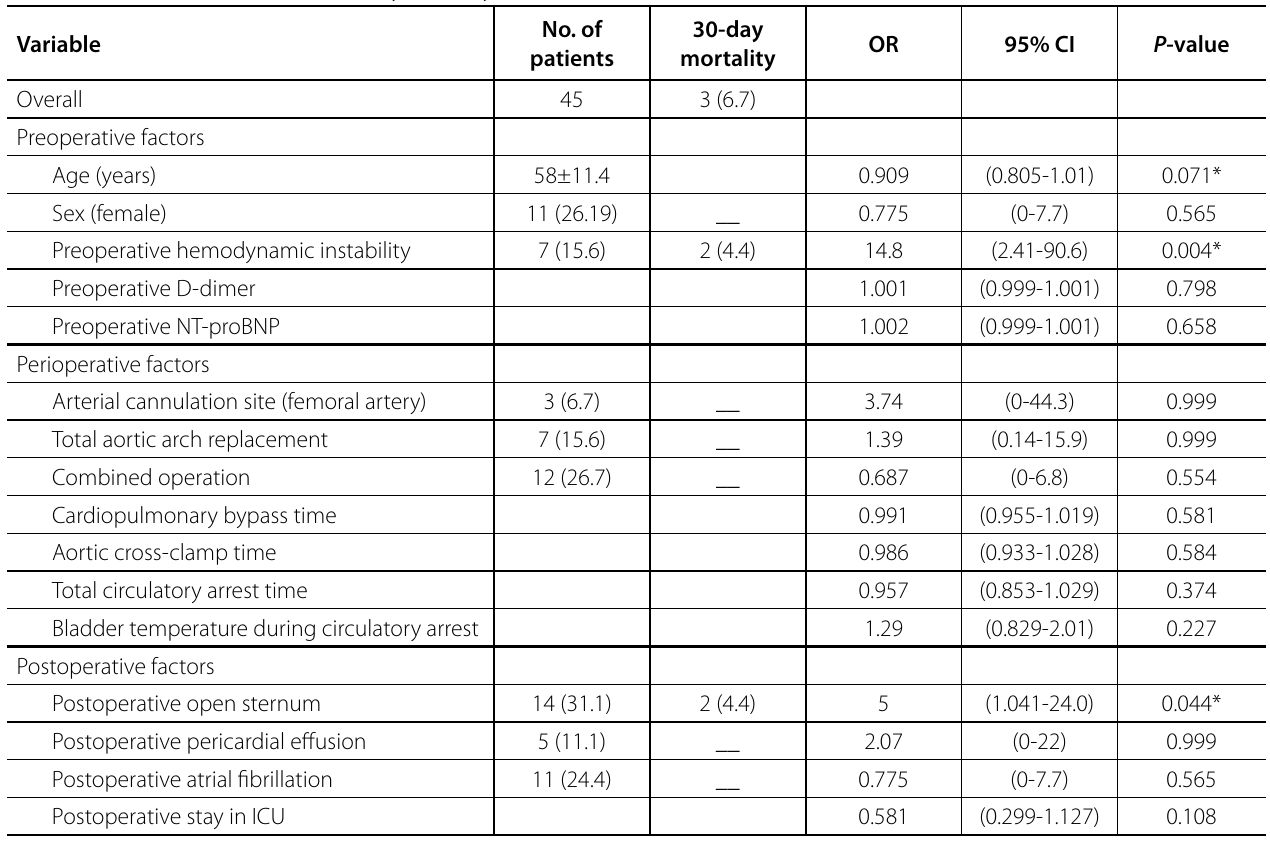
Table 4 . Univariate risk factors for 30-day